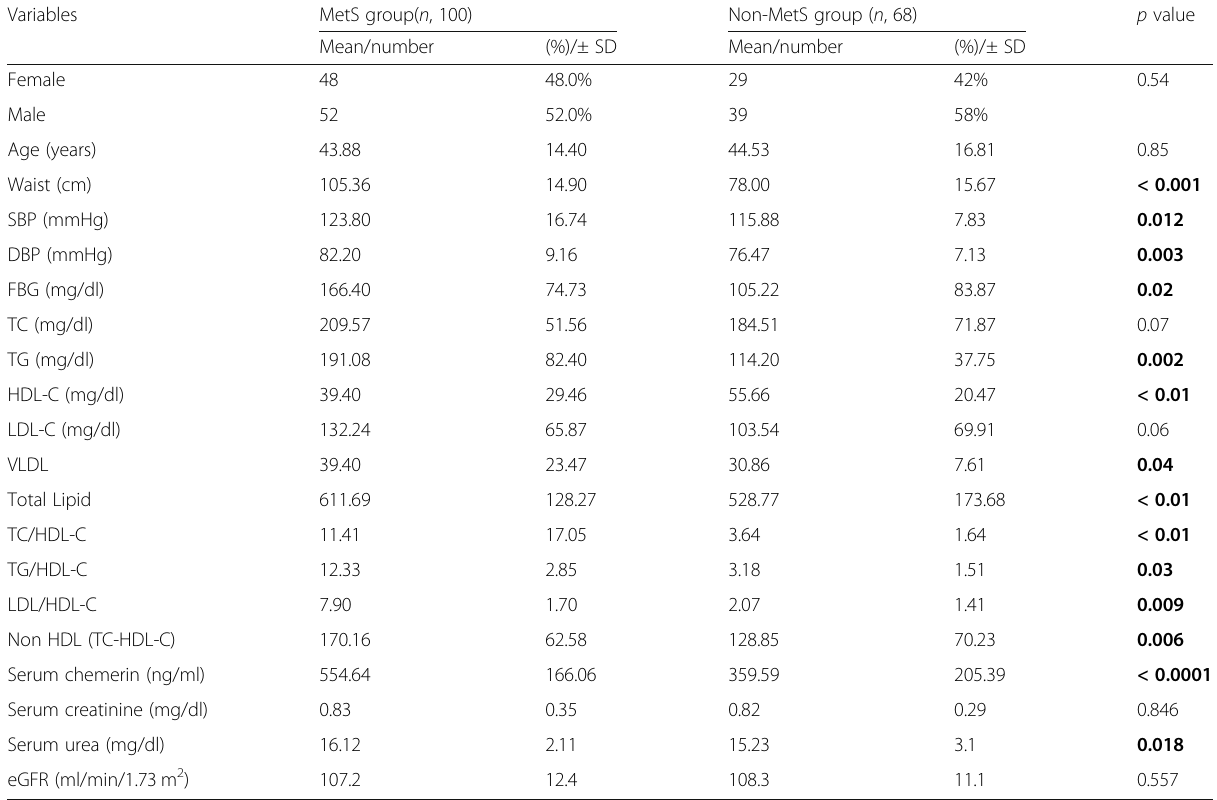
Table 1 Comparison between MetS group and non-MetS (control) group in relation to demographic data, MetS criteria, and biochemical parameters